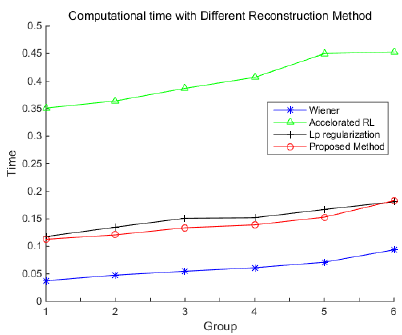
Figure 19. The computation time of different methods.